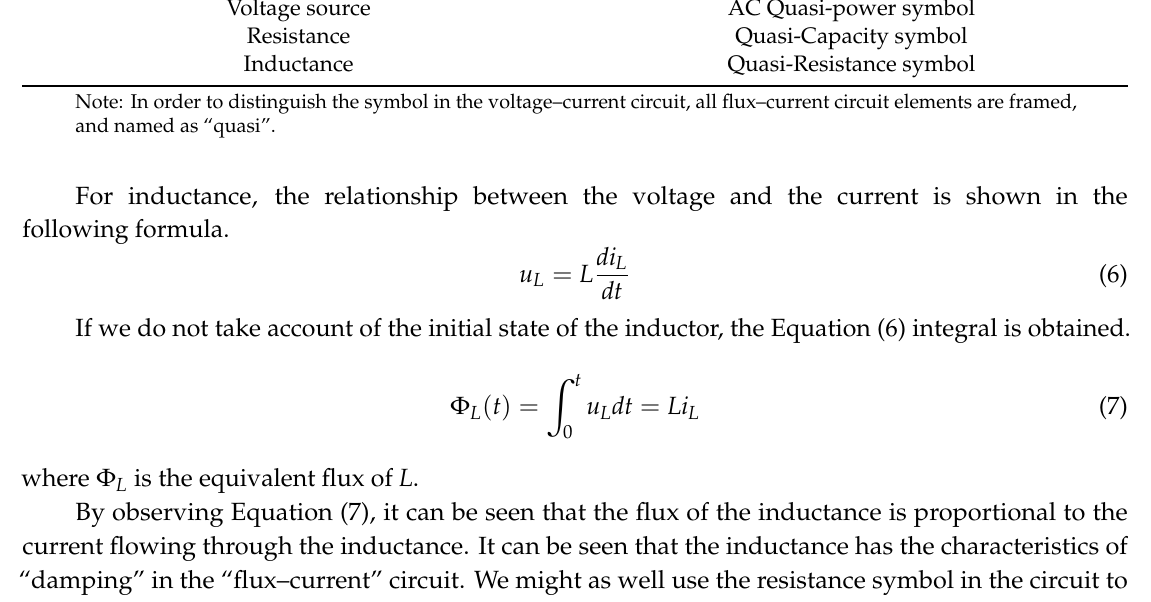
Table 1. Symbolic representation of elements in the “voltage-circuit” circuit in the “flux–current” circuit. Components in the “Voltage–current” Circuit In the “Flux–Current” Circuit